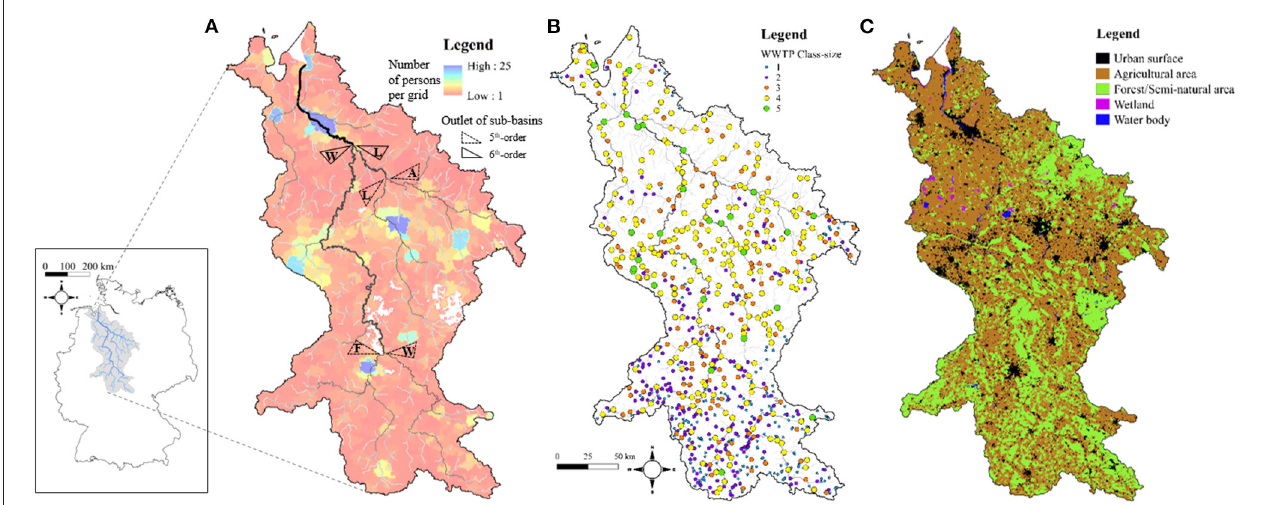
FIGURE 1 | Maps of human-related attributes distributed over the Weser River Basin of which location within Germany is shown in the most left figure. (A) Distribution of ∼ 8.4 million people as the number of persons per grid with a range from 1 to 25. River network with the final 7th order is overlaid with black lines of which thickness and brightness are proportional to stream-orders. Dashed and solid triangles indicate the outlets of four sub-basins with 5th-order (F, W, L, and A for Fulda, Werra, Leine, and Aller) and two sub-basins with 6th-order (W and L for Weser and Leine), respectively. (B) Distribution of ∼ 845 WWTPs categorized as five class-sizes of which color-codes are given in the legend. (C) Distribution of five types of land-cover of which areas are visualized with different colors [ (B,C) were adapted from Yang et al. Copyright (2021), with permission from